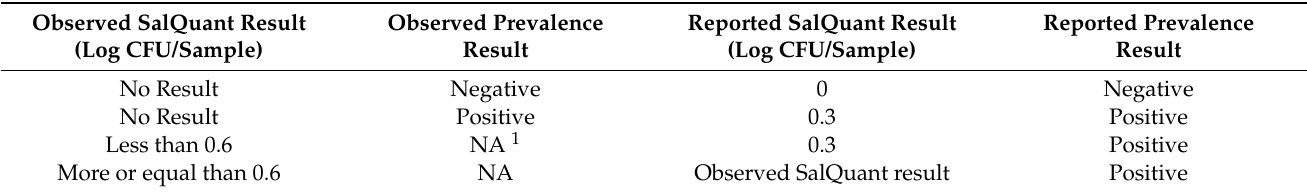
Table 3. Observed and reported parameters established for Salmonella spp. quantification and prevalence analysis.